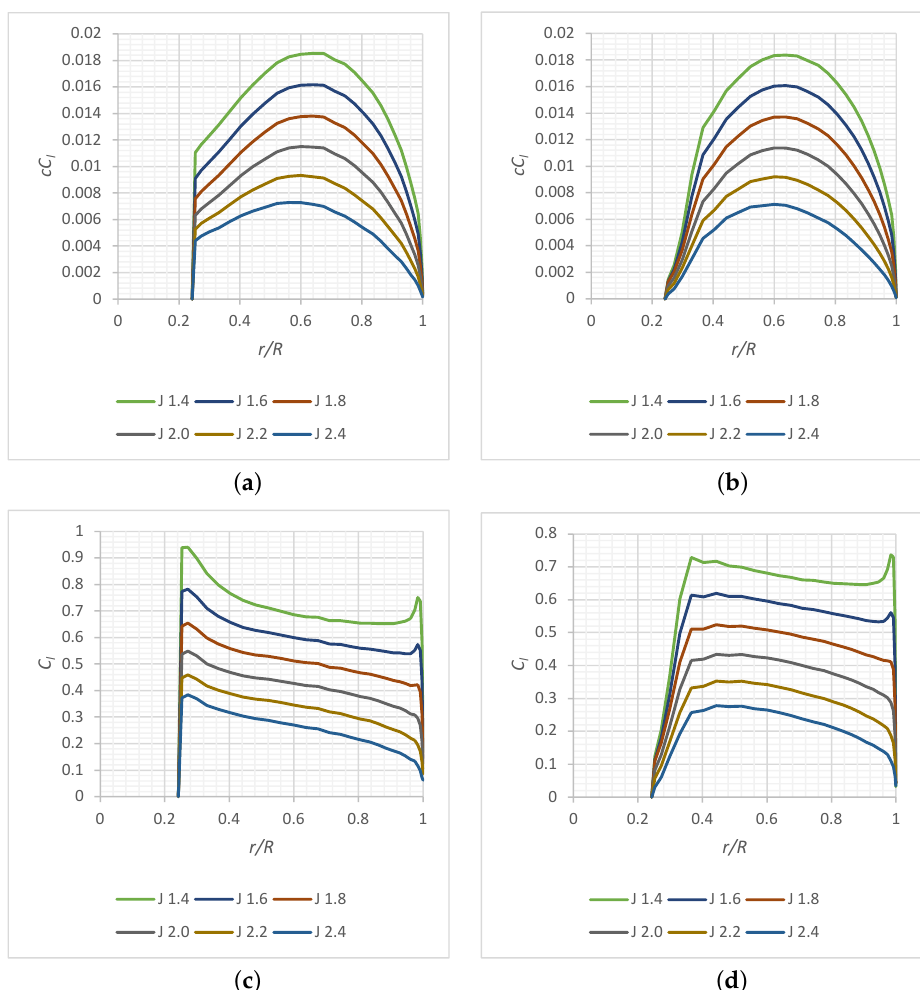
Figure A1. Numerical blade distributions: ( a ) aerodynamic loading on the original blade; ( b ) aerody- namic loading on the modified blade; ( c ) profile lift coefficient on the original blade; ( d ) profile lift coefficient on the modified